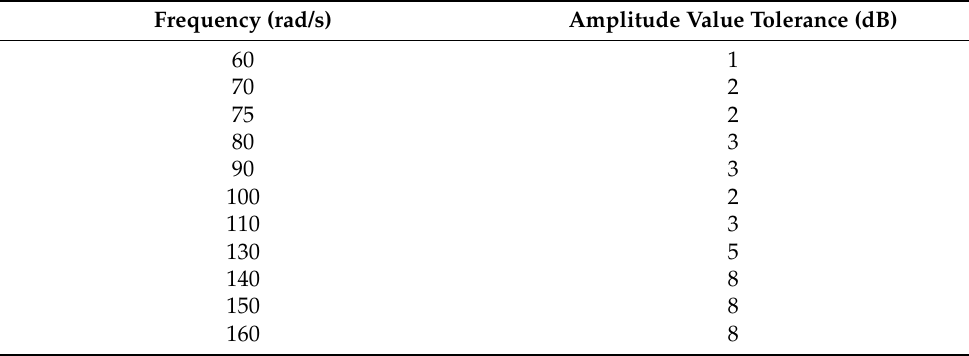
Table 2. The amplitude value tolerances at the selected frequencies.